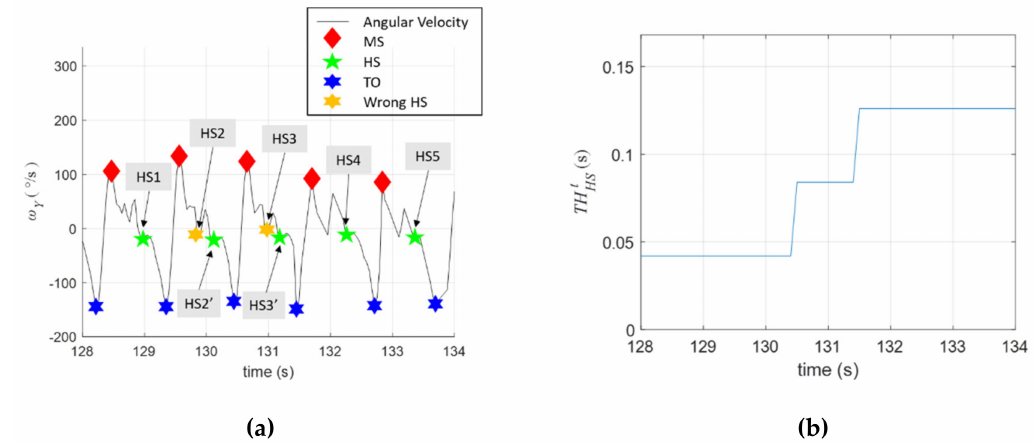
Figure 5. Identification of the HS events. ( a ) Labelling of the HS events; ( b ) online adjustment of TH t